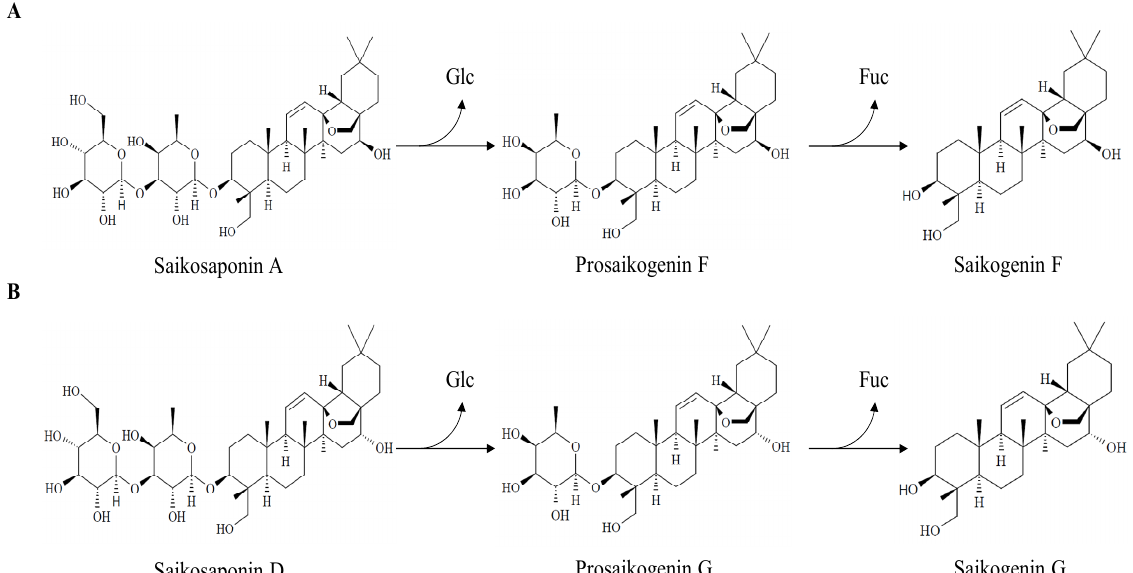
Figure 2. Biotransformation pathway of saikosaponins. ( A ) Biotransformation pathway of saikosaponin A into saikogenin F via prosaikogenin F by BglPm; ( B ) Biotransformation pathway of saikosaponin D into saikogenin G via prosaikogenin G by BglLk.